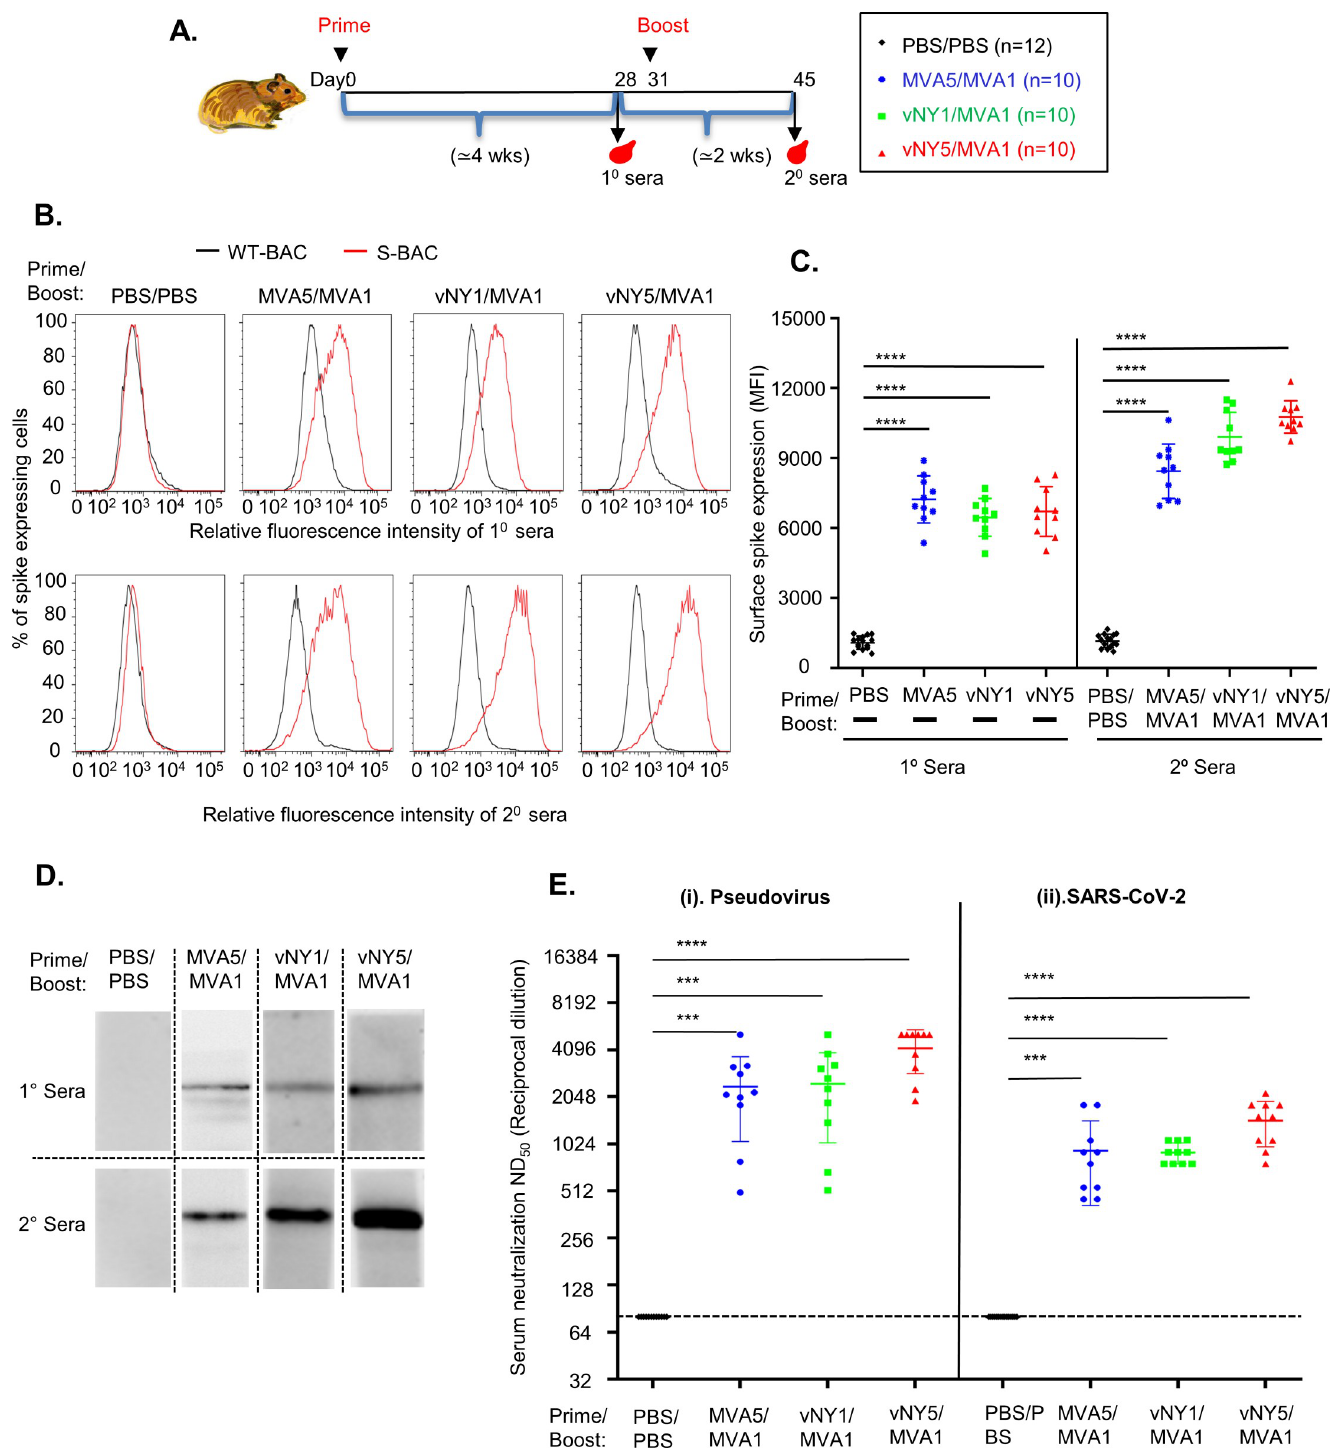
Fig 4. MVA5/MVA1, vNY1/MVA1 and vNY5/MVA1 prime-boost vaccination regimens generated SARS-CoV-2 spike-specific neutralizing antibodies in Syrian hamsters. (A). Timeline for hamster immunization and sera collection. (B). Primary and secondary sera from immunized hamsters recognized SARS-CoV-2 S protein on cell surfaces. Hamster sera collected 4 weeks after priming (1˚ sera) and 2 weeks after boosting (2˚ sera) were assessed for SARS-CoV-2-specific IgG antibodies by flow cytometry using SF9 cells infected with either S-BAC (red line) or WT-BAC (black line). A single representative serum is shown in each histogram. (C). Quantification of anti-spike antibody titers in 1˚ and 2˚ sera from hamsters in B, using the mean fluorescence intensity (MFI) value from FACS. Numbers of